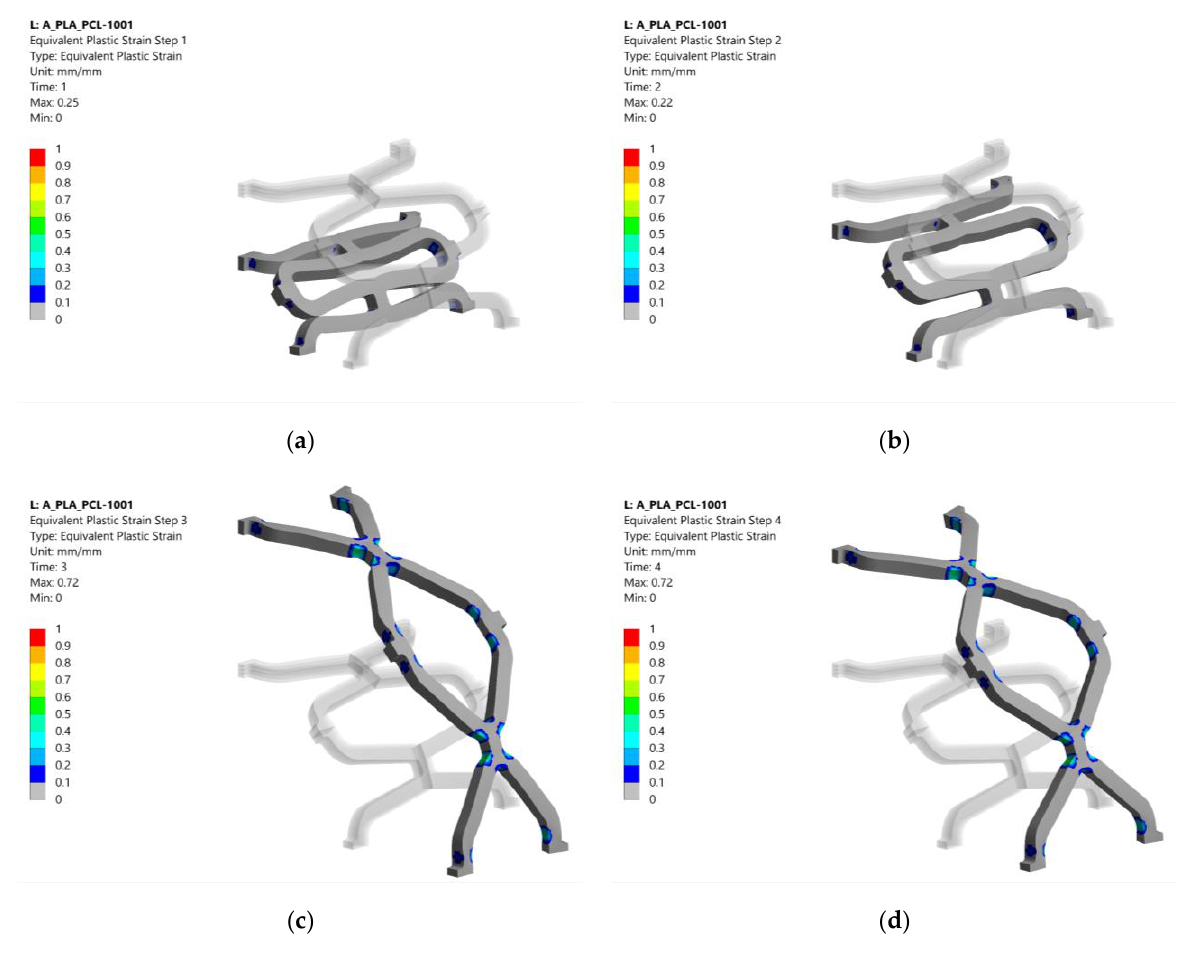
Figure 8. Equivalent plastic strain results for configuration 1001 (deformation scale factor: 1): ( a ) plastic strain after crimping; ( b ) plastic strain after crimper removal; ( c ) plastic strain after expansion; ( d ) plastic strain after balloon removal.